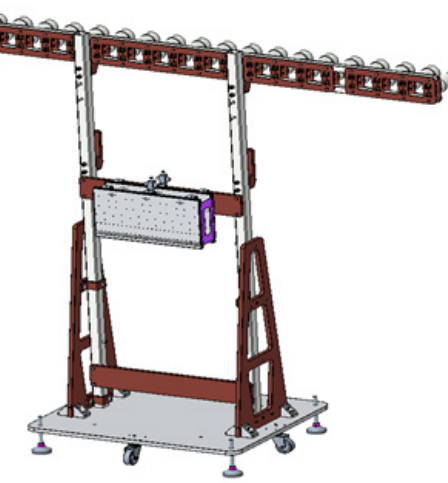
Figure 6. Low-frequency broadband plane wave antenna array structure.